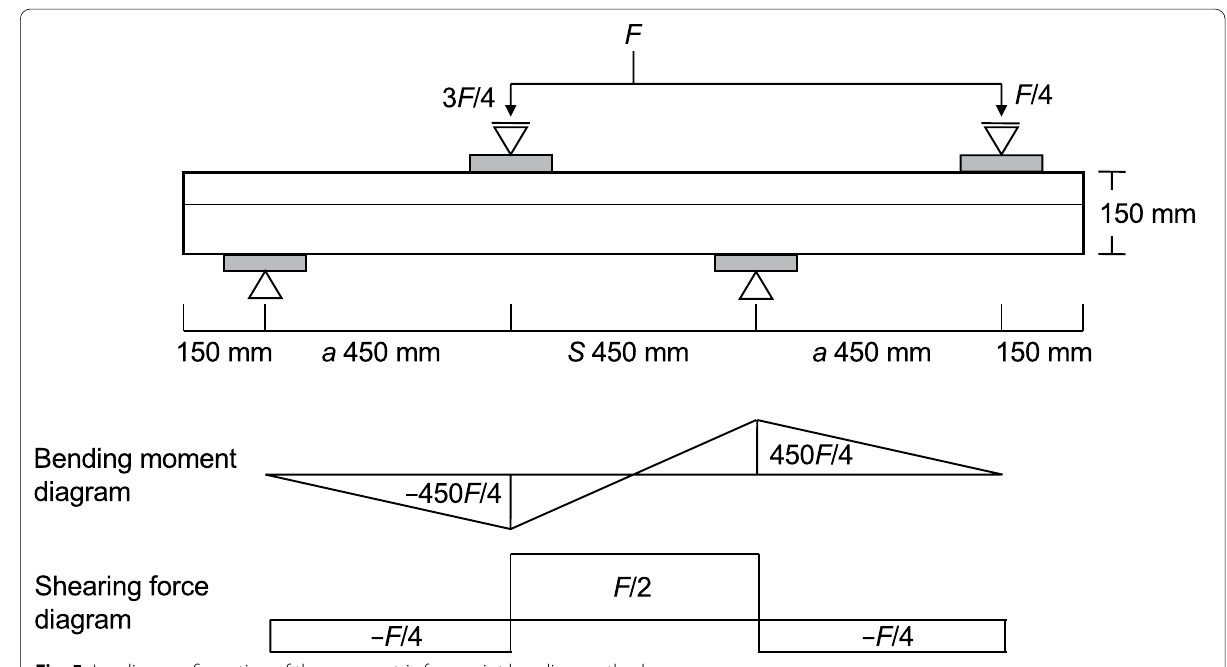
Fig. 5 Loading configuration of the asymmetric four-point bending